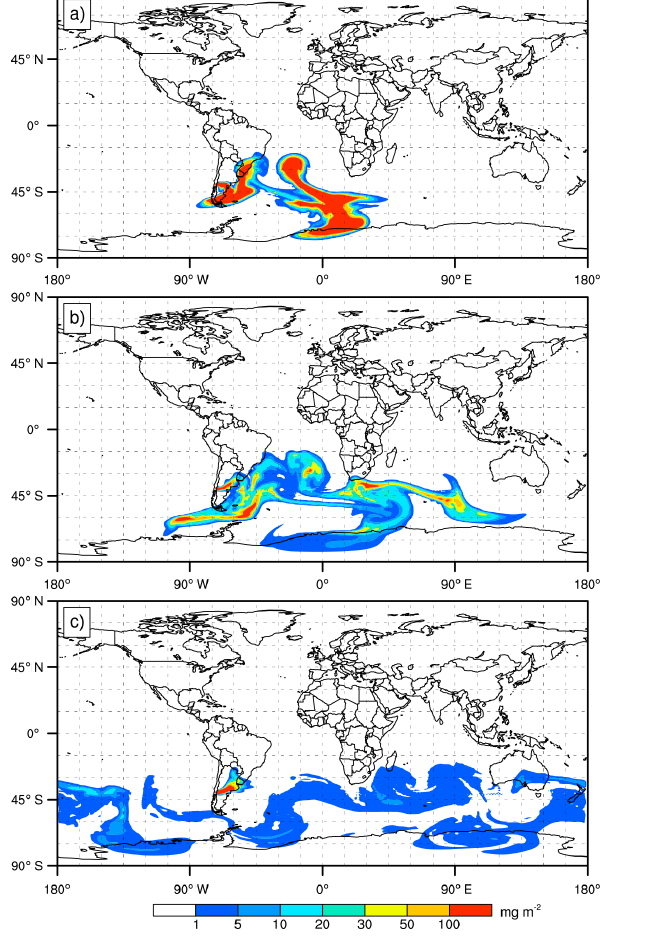
Table 8. Model configuration for the 2001 Mount Etna re- gional simulations. Regional Run1 used a horizontal resolution